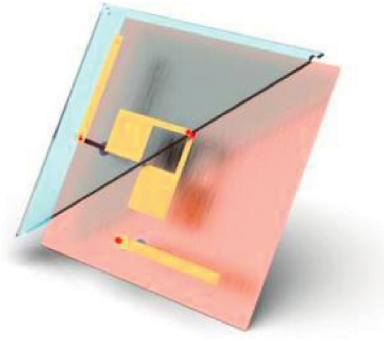
Figure 1: Configurations of the